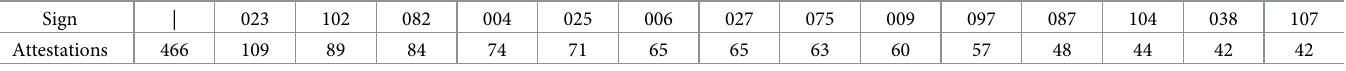
Table 1. Number of attestations for the 15 most frequent signs in the